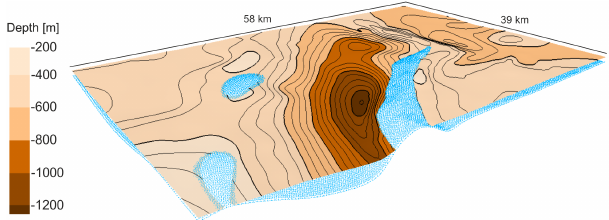
Figure 4. Depth contour map of the top of the Rupelian clay barrier with discontinuities where Cretaceous sediments penetrate the Ru- pelian clay barrier. The top of the Cretaceous is displayed as blue mesh. Vertical exaggeration is 2 :